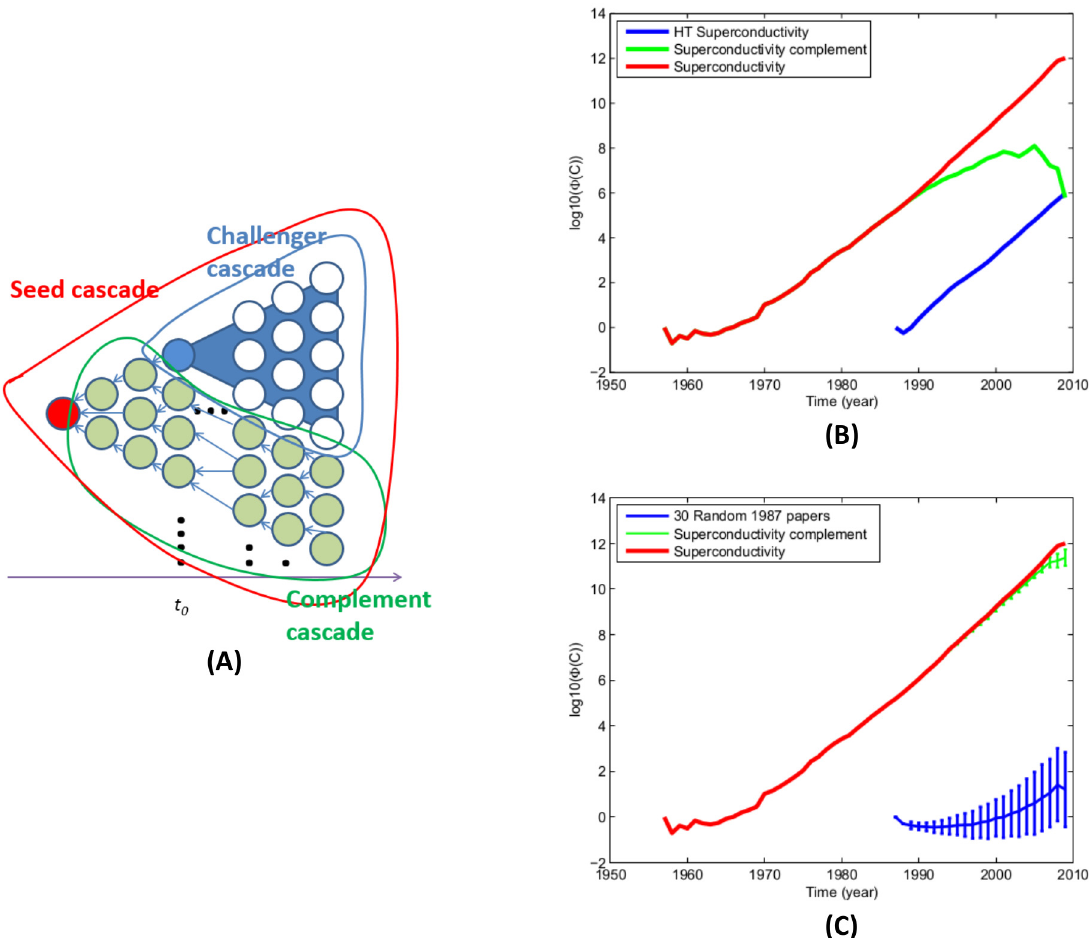
Fig 2. Disruption of the influence of the seed by a challenger can be observed in the changes to the citation cascade of the seed. (A) A citation cascade of a seed paper and residue cascade created by subtracting a challenger ’ s cascade. (B) An example of the disruption of the superconductivity theory (BCS) by the high temperature superconductivity theory (HTS). (C) 30 randomly selected papers published in the same year show no sign of cascade disruption to BCS, though the annual standard variation bars show that the growth of their own cascades are highly variant (blue curve). Meanwhile, the annual standard deviation bars of the growth of the residue cascades that they yield are